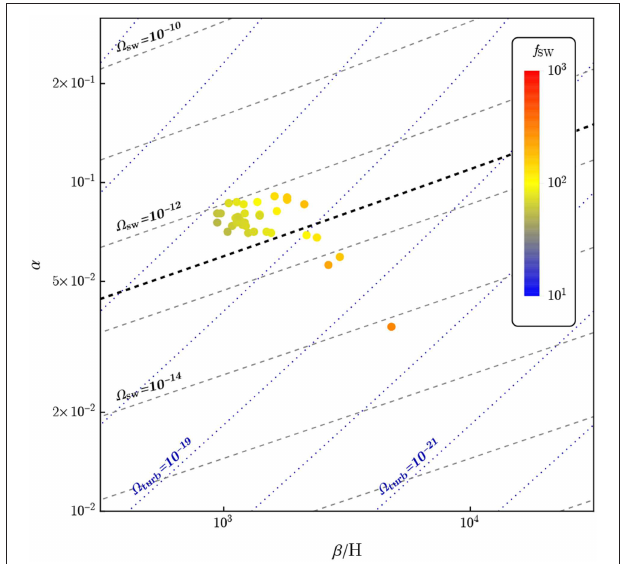
FIGURE 7 | Plane of thermal parameters with contours of constant sound wave (in black) and turbulence (in blue) peak amplitude. The thicker line shows the peak sensitivity of the Einstein telescope [338]. Points denote thermal parameters produced by a Pati-Salam phase transition with a Pati-Salam scale of M PS 10 5 GeV. The peak frequency for the sound wave spectrum is = indicated by the color scaling. Figure taken from Croon et al. [